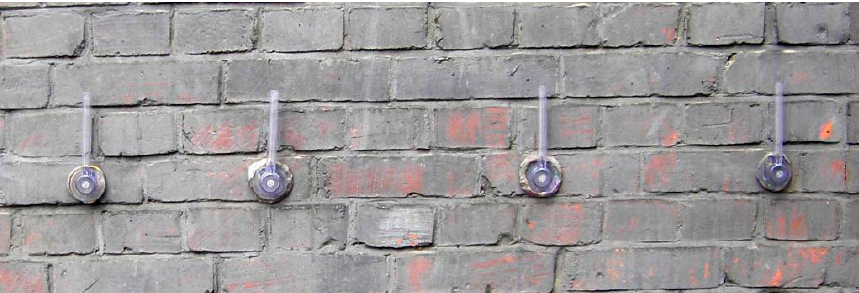
Figure 4. Measurement of capillary absorption of the masonry wall with the use of Karsten tube.